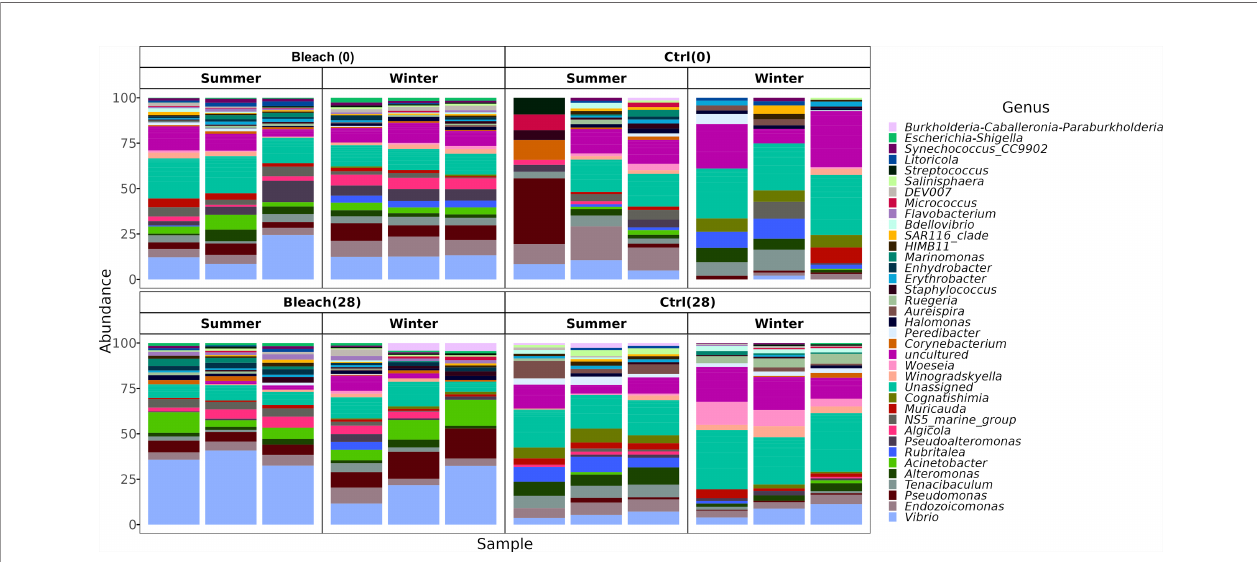
FIGURE 4 | The bacterial composition of medusas at the genus taxonomic level. Bar plots display the bacterial composition in the mucus of all samples (Control and bleached medusas, at days 0 and 28) in summer and winter. The 40 most abundant genera were plotted and distinguished by color. For a relative abundance of all genera, see Supplementary Material 3